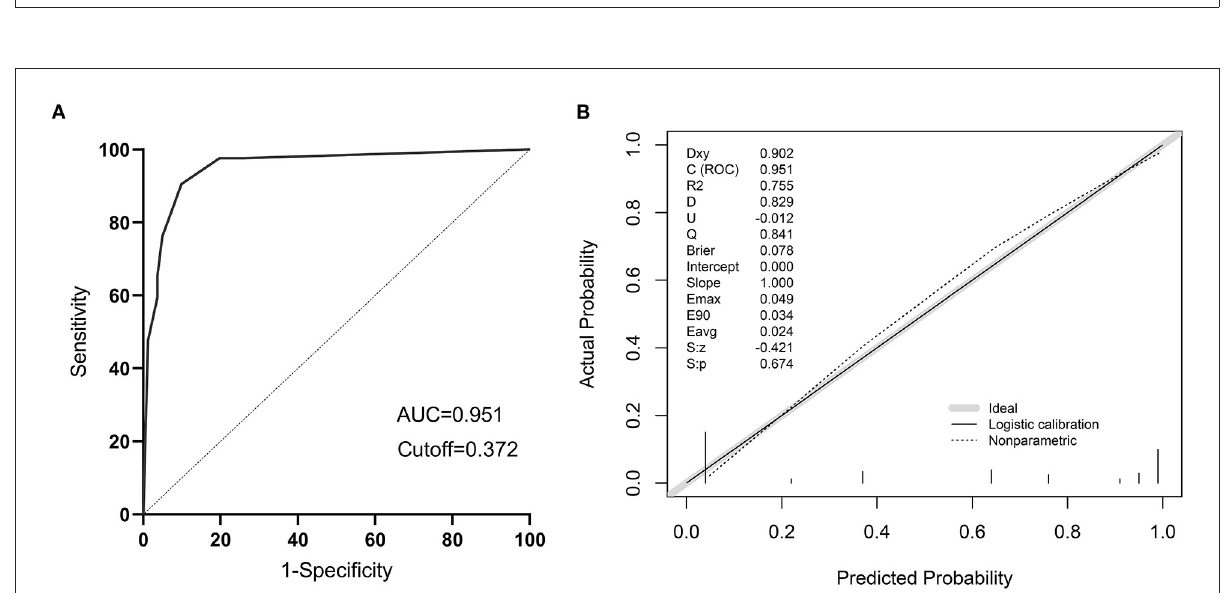
FIGURE9 The validation of a predictive model for the risk of sepsis in infected patients. (A) ROC curve of the prediction model for the risk of sepsis in infected patients; (B) Calibration curve of the model for the risk of sepsis in infected